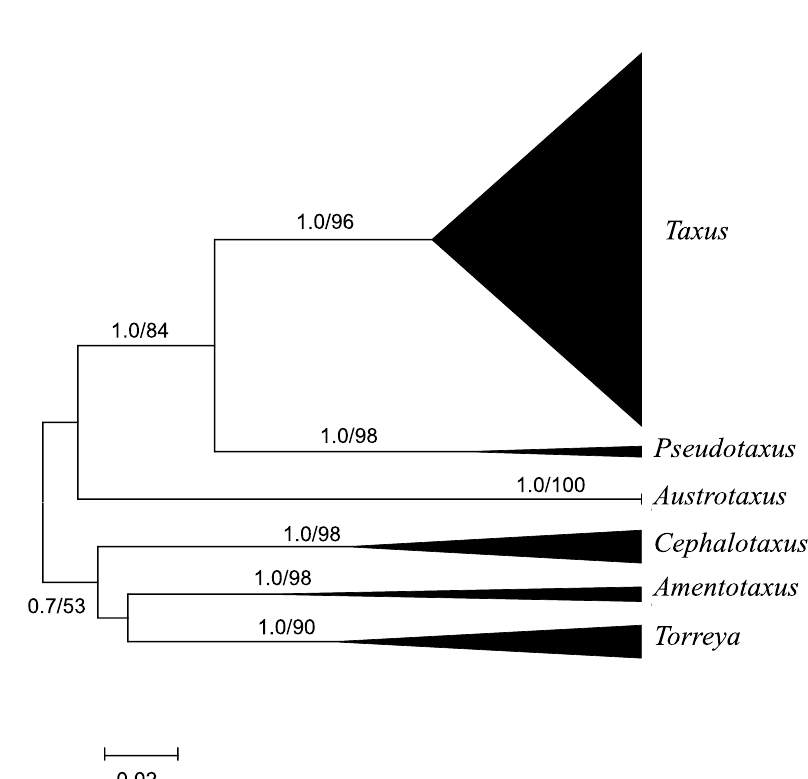
Figure 2. Mid-point rooted maximum likelihood phylogenetic reconstruction of Taxaceae based on trnL and trnL–F plastid DNA. Scale is genetic distance. Bayesian inference posterior probabilities shown before slash and maximum likelihood bootstrap (BS) values after the slash. 132 sequences were included so the terminal branches were too small to read individually and were condensed to triangles, but the full trees are available in Supplementary Figures S1 and S2.